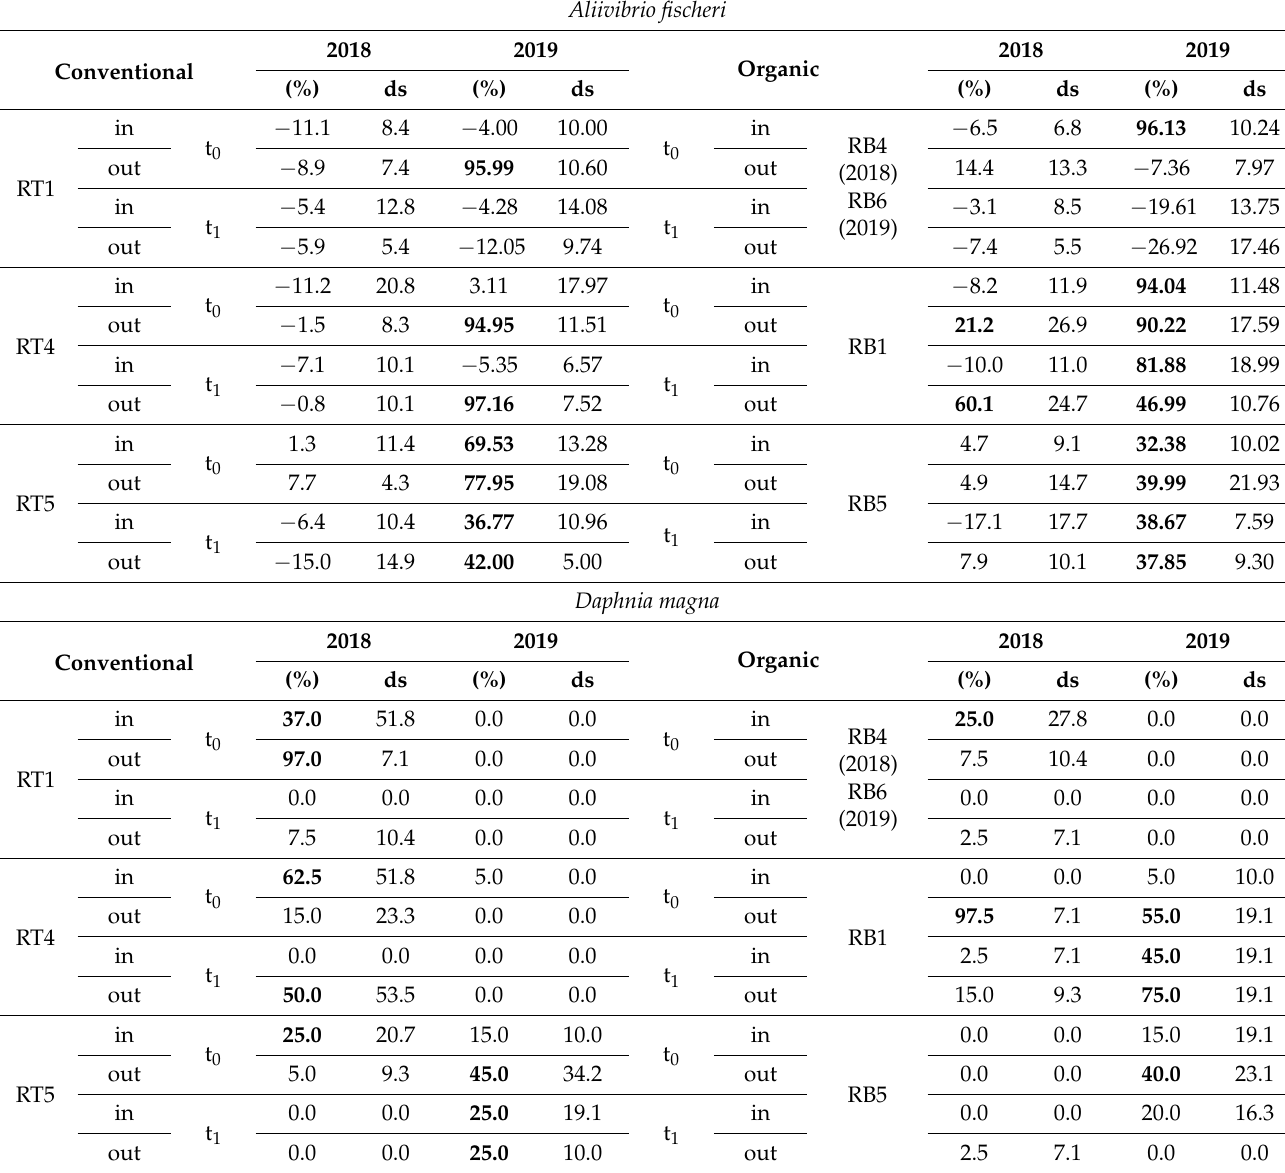
Table 6. Bioassay results expressed as percent effect (%) with standard deviation (sd) on paddy water samples collected during campaigns t 0 and t 1 before and after PPPs treatment; in and out labels refer to samples taken from streams entering and exiting the paddy water chamber; boldface indicates inhibition effects above the toxicity thresholds; negative sign indicates biostimulation in comparison to the